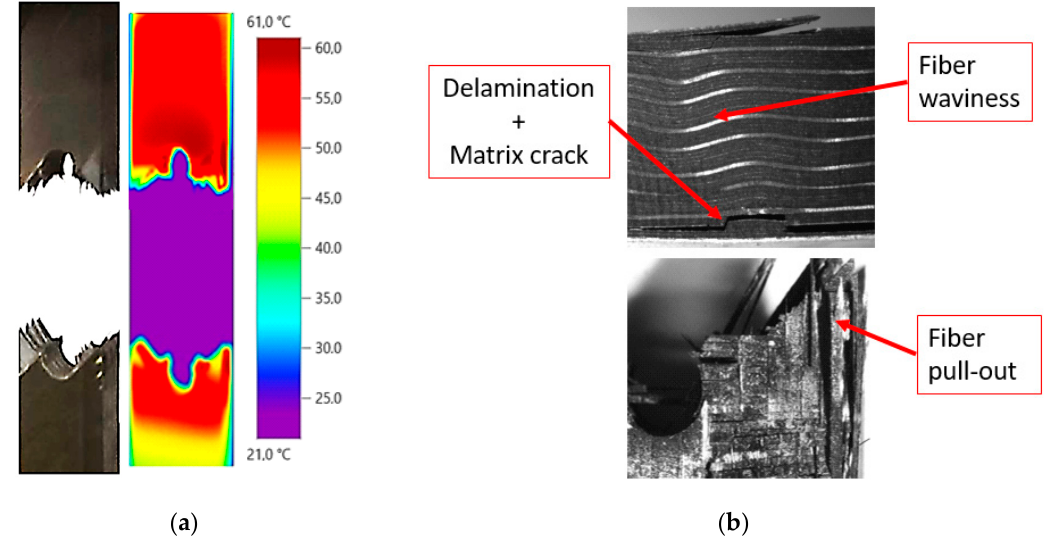
Figure 9. ( a ) Specimen temperature at breakage time for geometry A and ( b ) failure mechanisms observed under optical microscope after breakage.